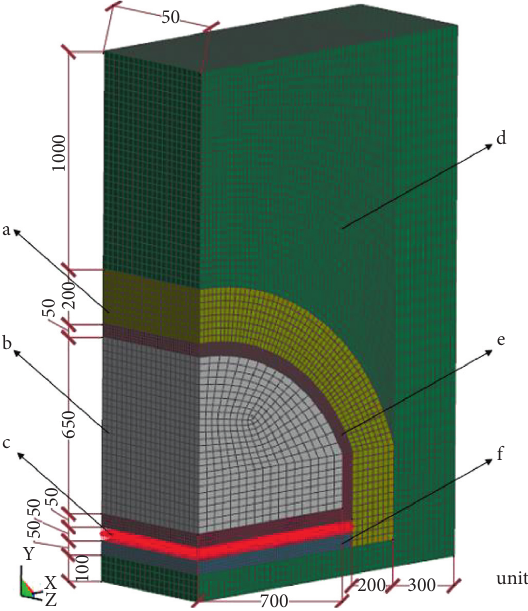
Figure 1: The schematic diagram of the calculation model for underground arch structure with elastic support. (a) Rock anchor reinforcement. (b) Air. (c) Elastic support and damping support. (d) Surrounding rock. (e) Reinforced concrete straight wall arch. (f) Reinforced concrete bedding.